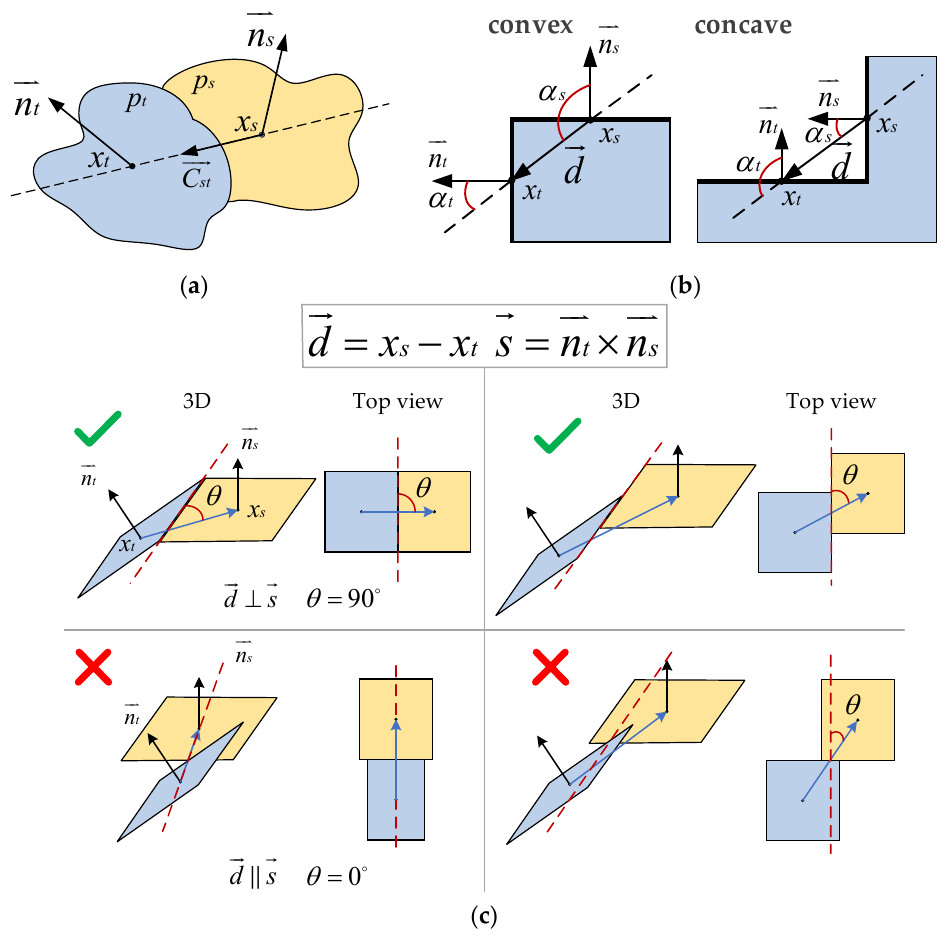
Figure 8. Geometrical relationship of two patches. ( a ) Features of two patches. ( b ) Geometrical meaning of convex-concave criterion. ( c ) Geometrical meaning of the sanity criterion.